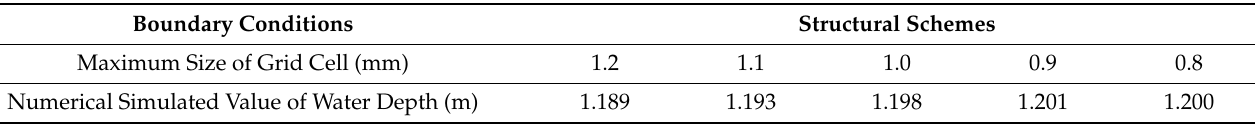
Table 2. Relationship between the maximum elements of the grid and the numerical results. Boundary